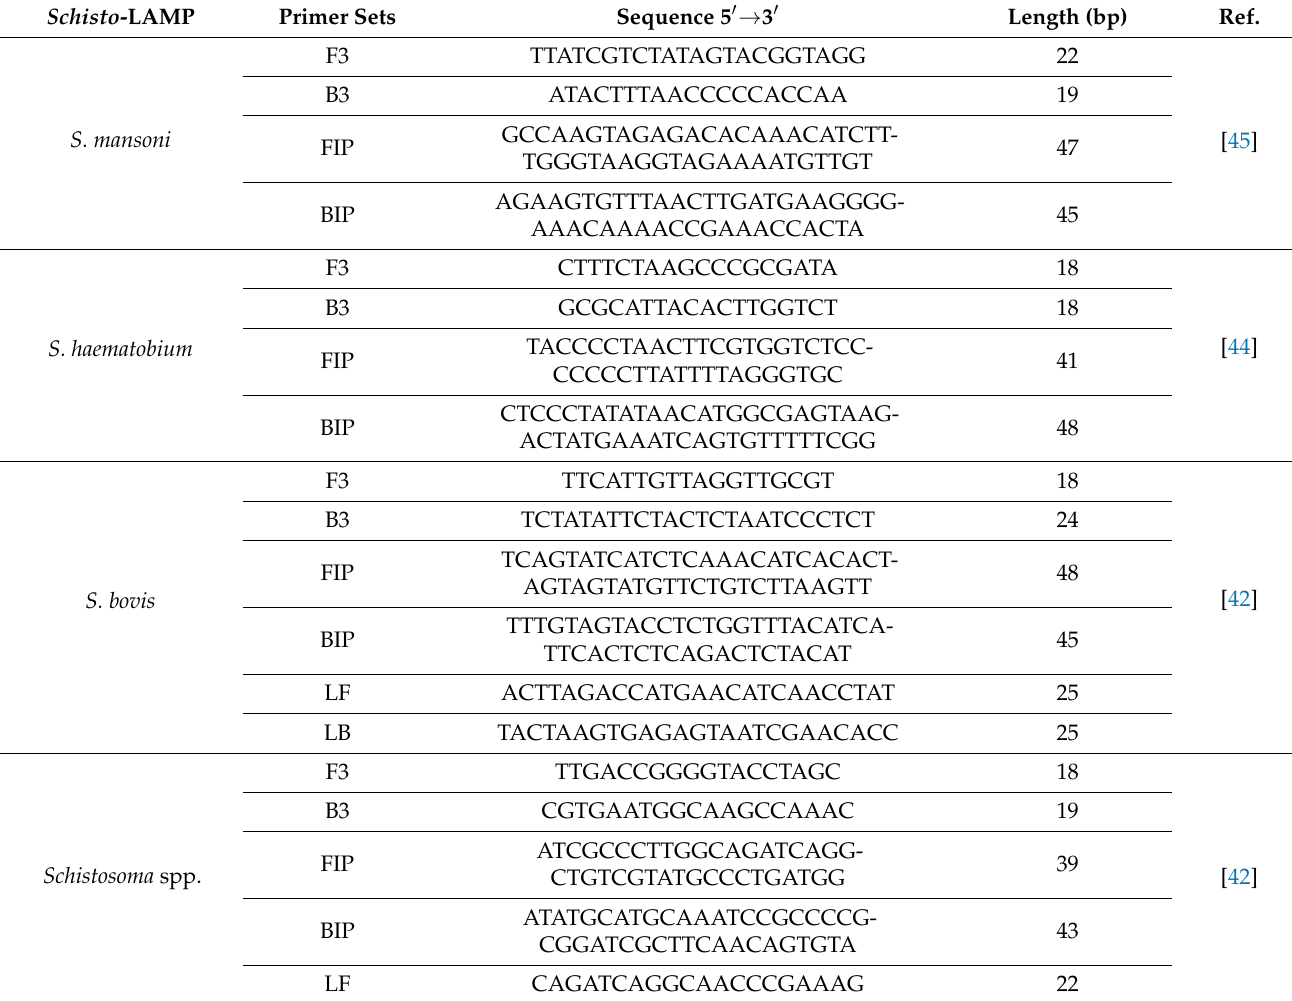
Table 2. Primer sets used in this work for Schisto -LAMP assays. For S. mansoni, S. haematobium , S. bovis and Schistosoma spp.: F3, forward outer primer; B3, backward outer primer; FIP, forward inner primer (comprising F1c and F2 sequences); BIP, backward inner primer (comprising B1c and B2 sequences); LF, loop forward primer; LB = loop backward primer. bp, base